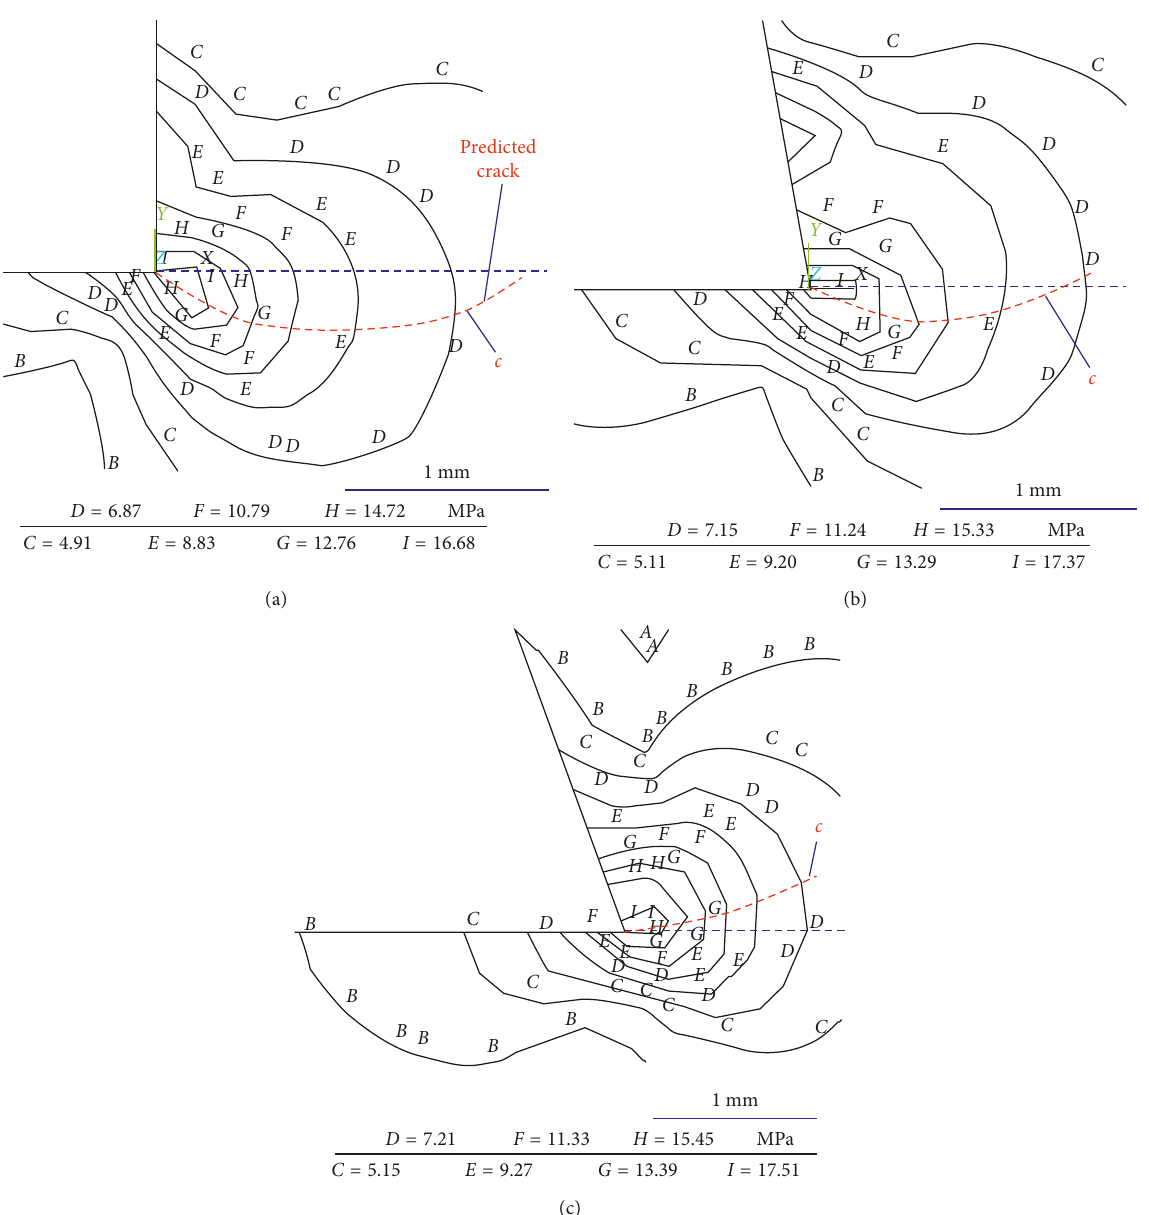
Figure 6: Effective stress contours in cutting zone and predicted crack propagation paths (the stresses in the vicinity of the tool tip just reach tension strength) at rakes angles of (a) 0 ° , (b) 10 ° , and (c) 20 °